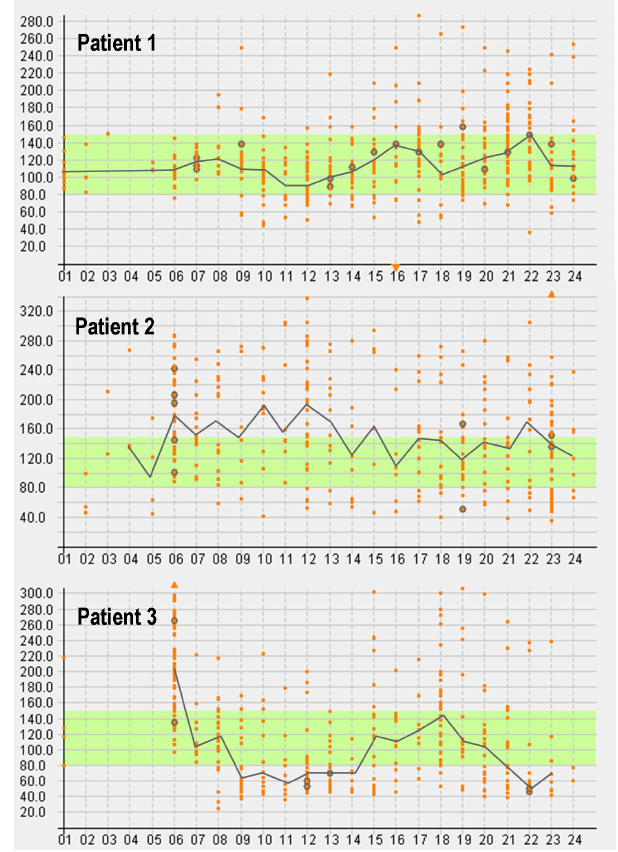
Table 4 adds characteristic values for the same three patients. Figure 5. Visualization of the 24-hour blood glucose profiles of three